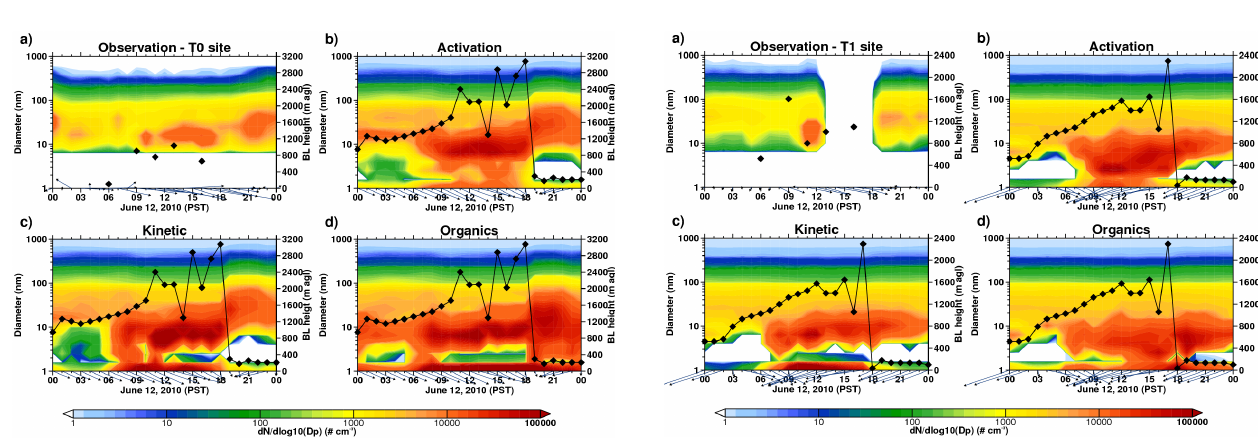
Figure 13. Number size distribution as a function of geometric di- ameter and time at the T0 site on 12 June 2010 from (a) obser- vations and the (b) ACT, (c) KIN, and (d) ORG simulations. The vectors along the bottom of each panel represent the observed and calculated winds at 10ma.g.l. at the T0 site. The maximum wind speed at about 12:00PST in (b) – (d) is 10.4ms − 1 . The black dia- monds represent the observed (a) and simulated ( b – d ) boundary- layer heights.